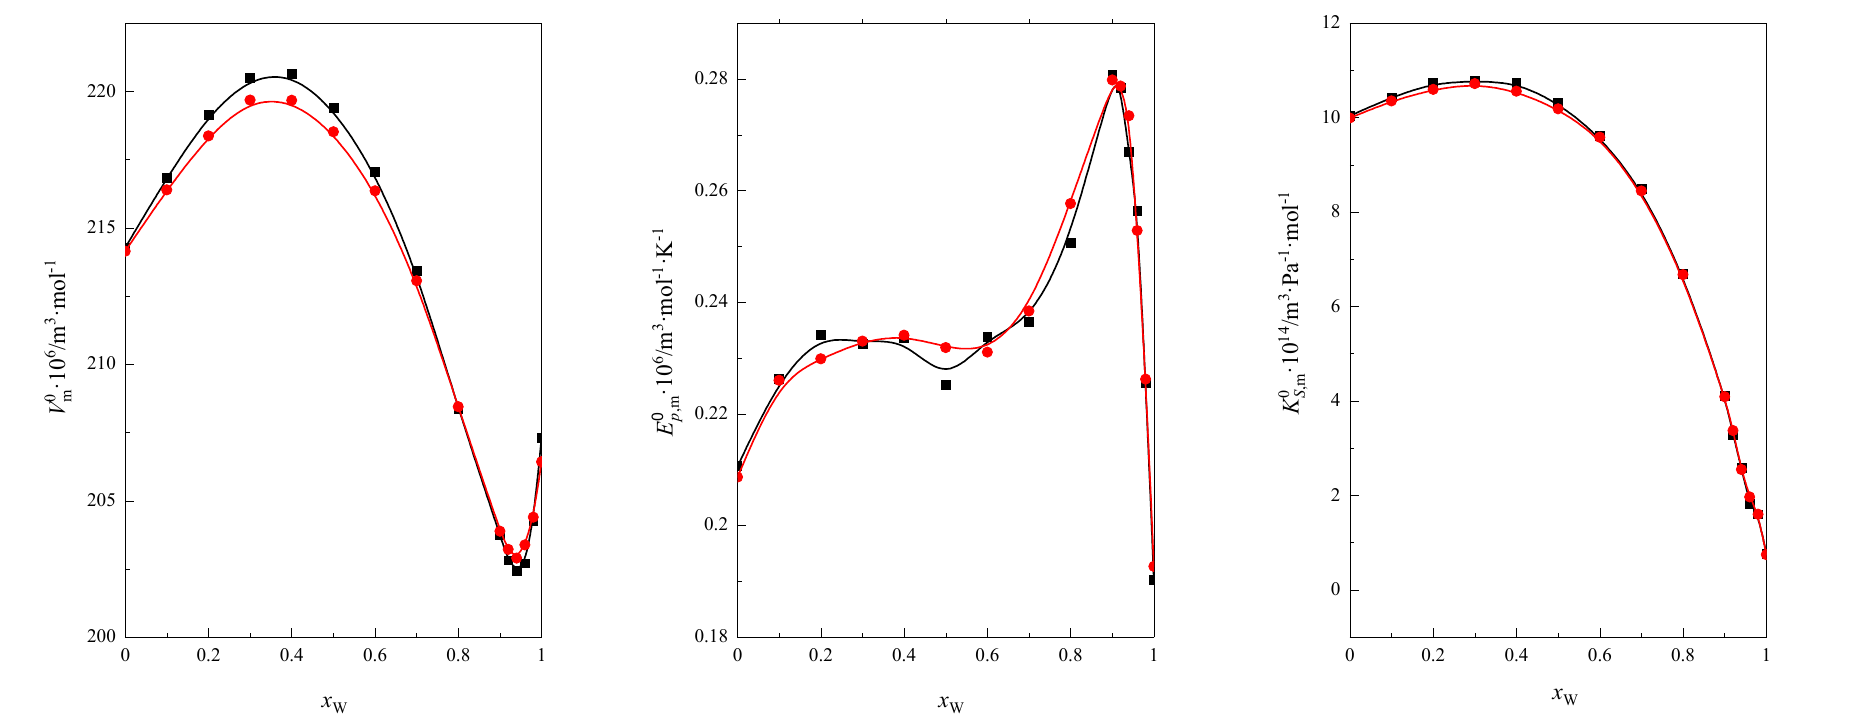
= f ( x ) for tetraglyme in the DMF + W mixed solvent at 298.15 K have been calculated ) 2 S ,m 0 K f x = for tetraglyme in the DMF + W mixed solvent at 298.15 K have been ,m 2 S